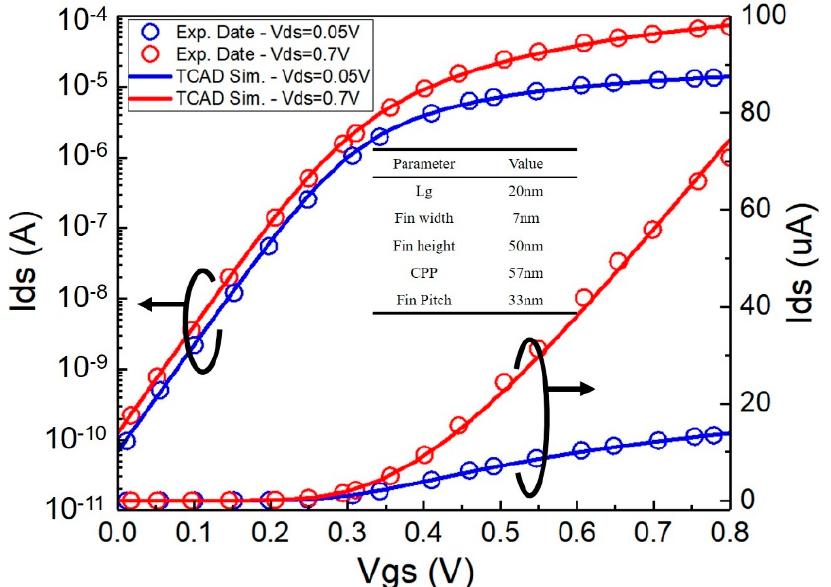
Figure 2. Physical model parameters calibrated to the mature 7 nm node Si-FinFET experimental data. Inset: Key geometry parameters of the fit device, of which the related parameters in the TCAD simulation is the same as [36] .